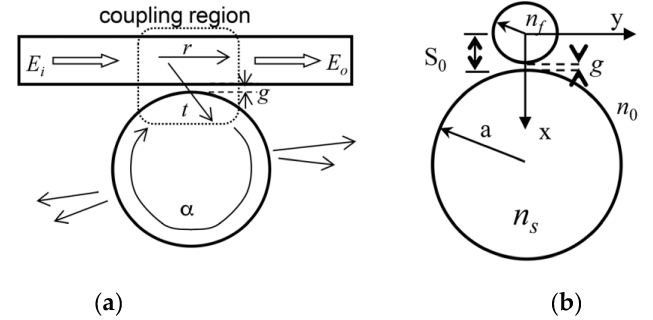
Figure 3. Scheme of a waveguide/fiber to microsphere coupling system: ( a ) lateral and ( b ) cross-sectional view. Reprinted with permission from